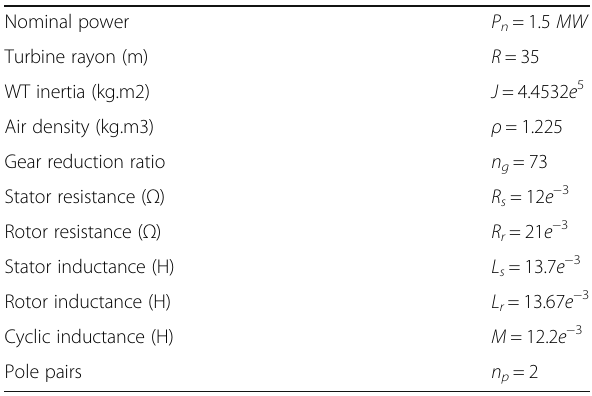
Table 1 WT-DFIG parameters Nominal